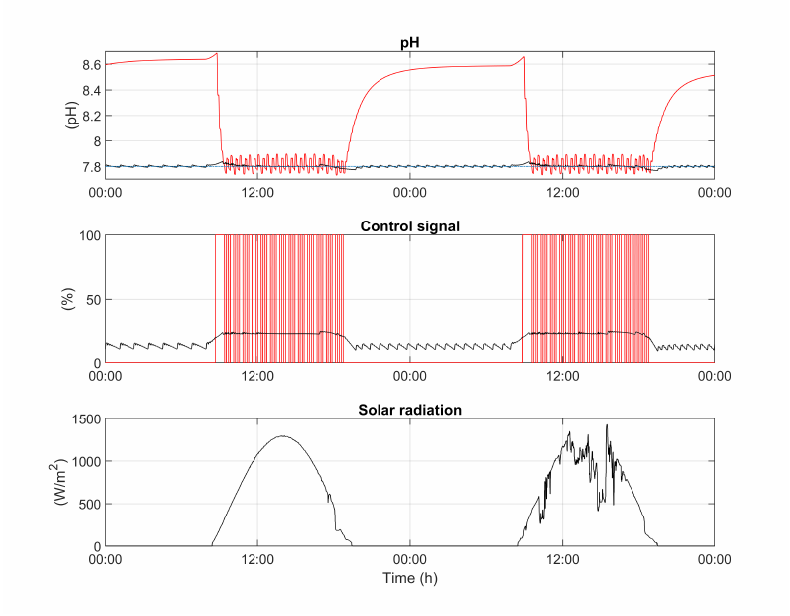
Figure 5. Two days comparison between traditional On/Off daytime control (red) and PI control during daytime and nighttime